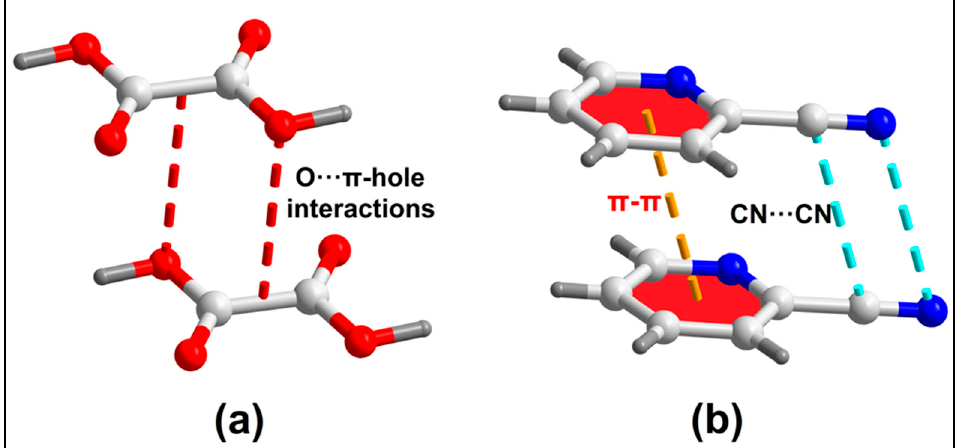
Figure 2. ( a ) Formation of supramolecular dimers of ox in 1 , assisted by unconventional O ··· π -hole interactions; ( b ) formation of supramolecular dimers of 4-CNpy in 1 , assisted by unusual parallel nitrile–nitrile and π -stacking